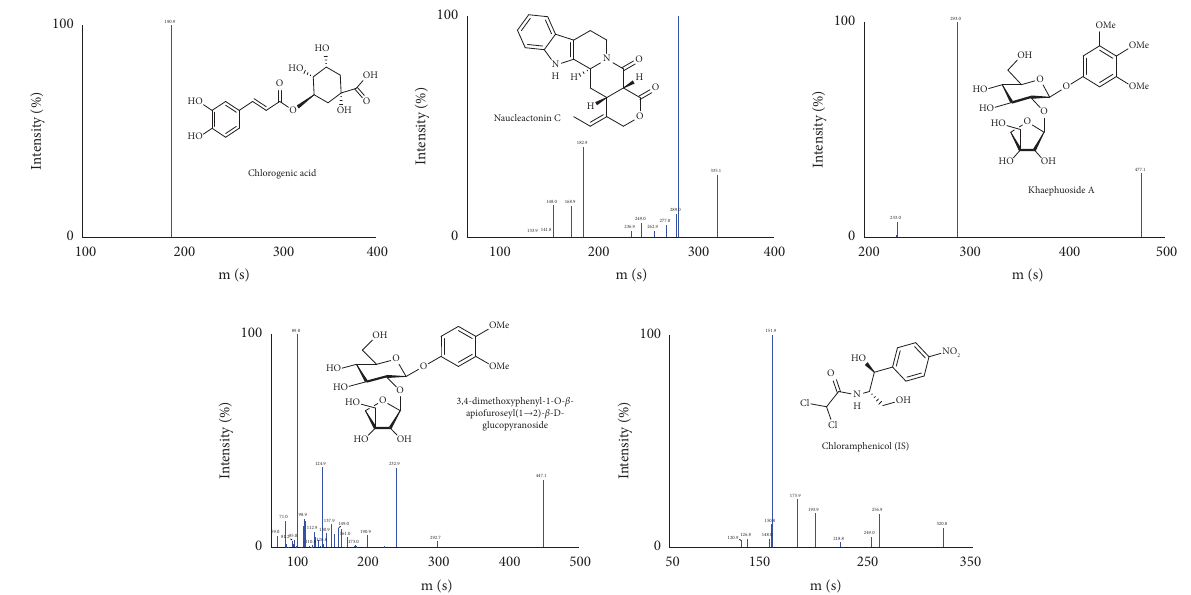
Figure 1: Chemical structures, precursor ion, and product ion mass spectra of four analytes and IS.